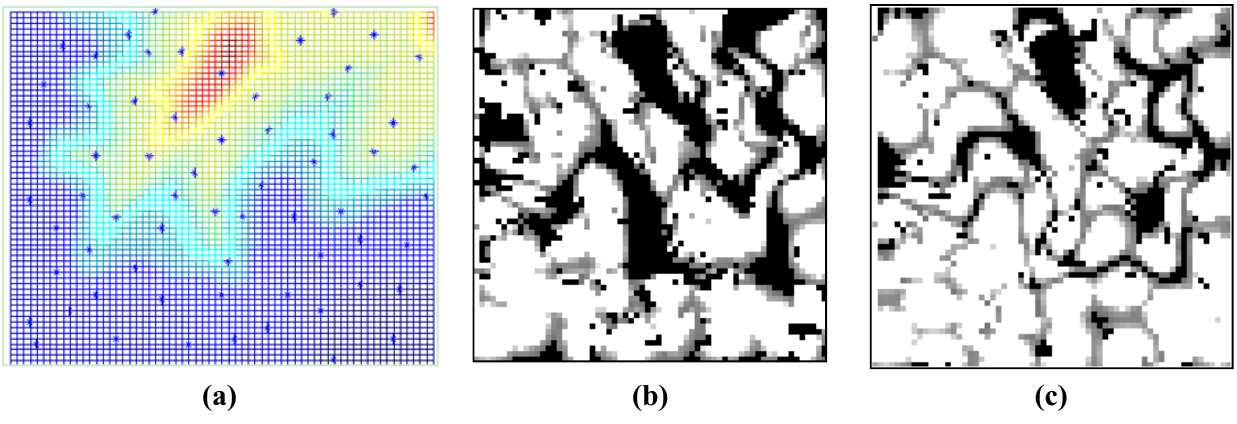
Figure 10. Final deployment results of WTDS-SGA method ( a ) optimally deployed sensors on the terrain; ( b ) the coverage matrix after first generation (black regions represent coverage holes); ( c ) the coverage matrix after last